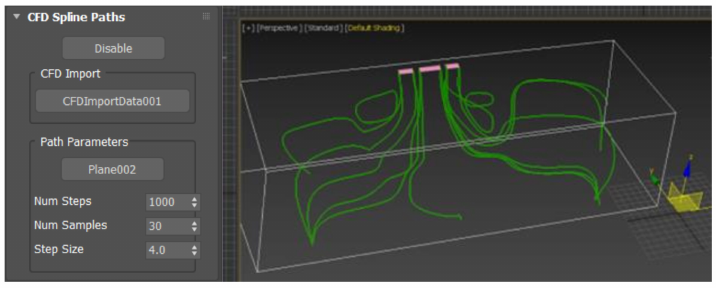
Figure 8. Creating the